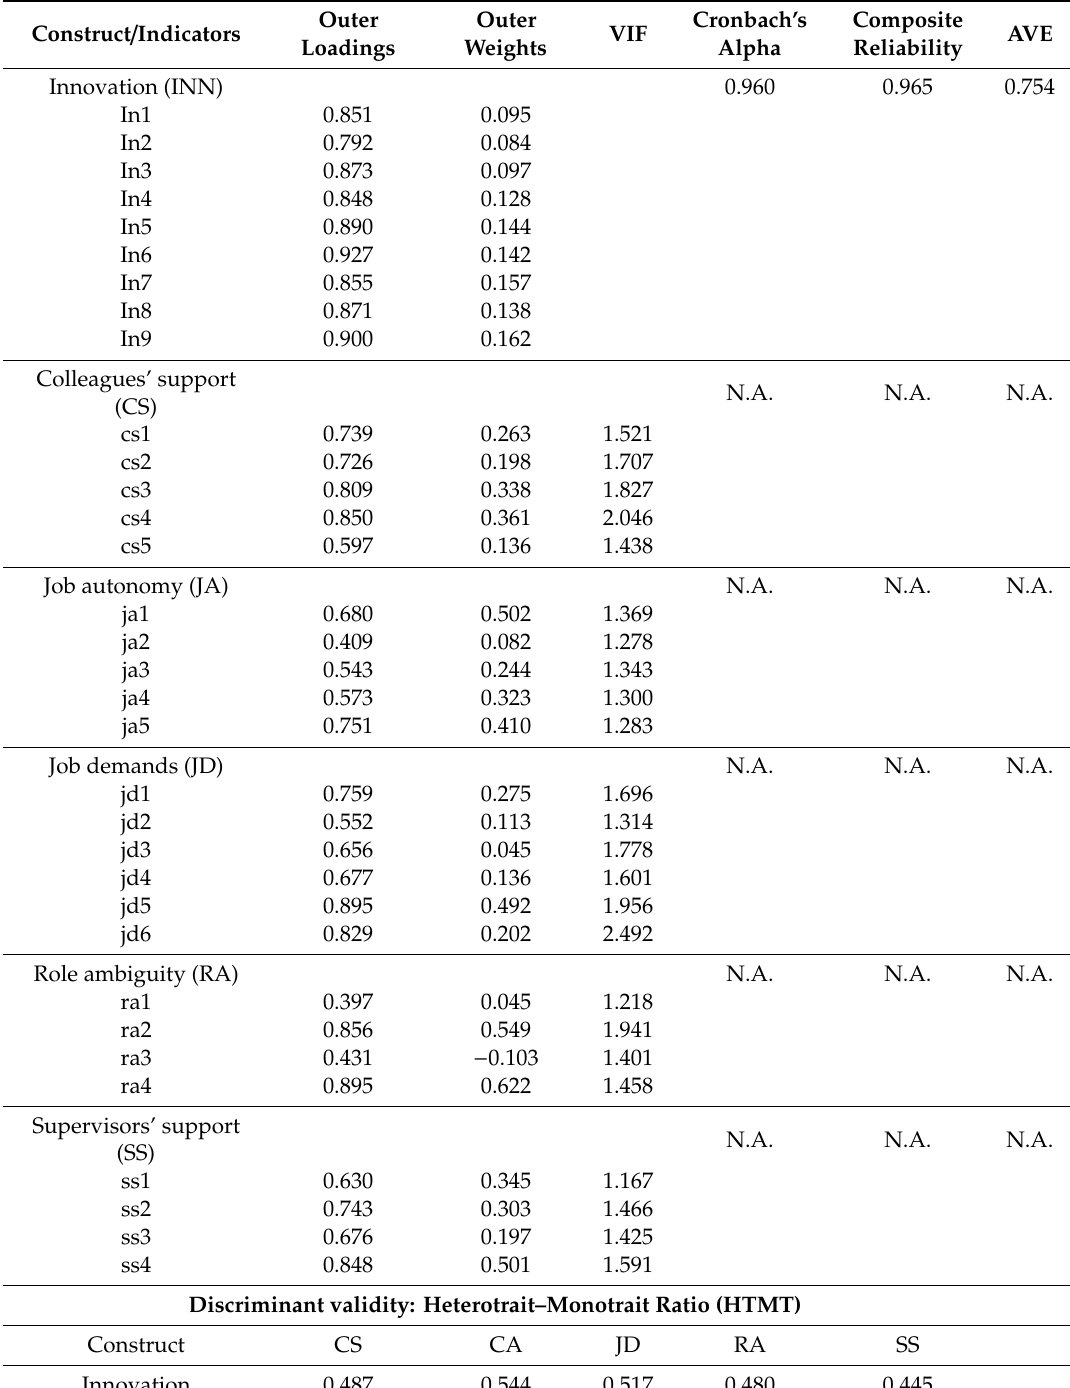
Table 1. Measurement model